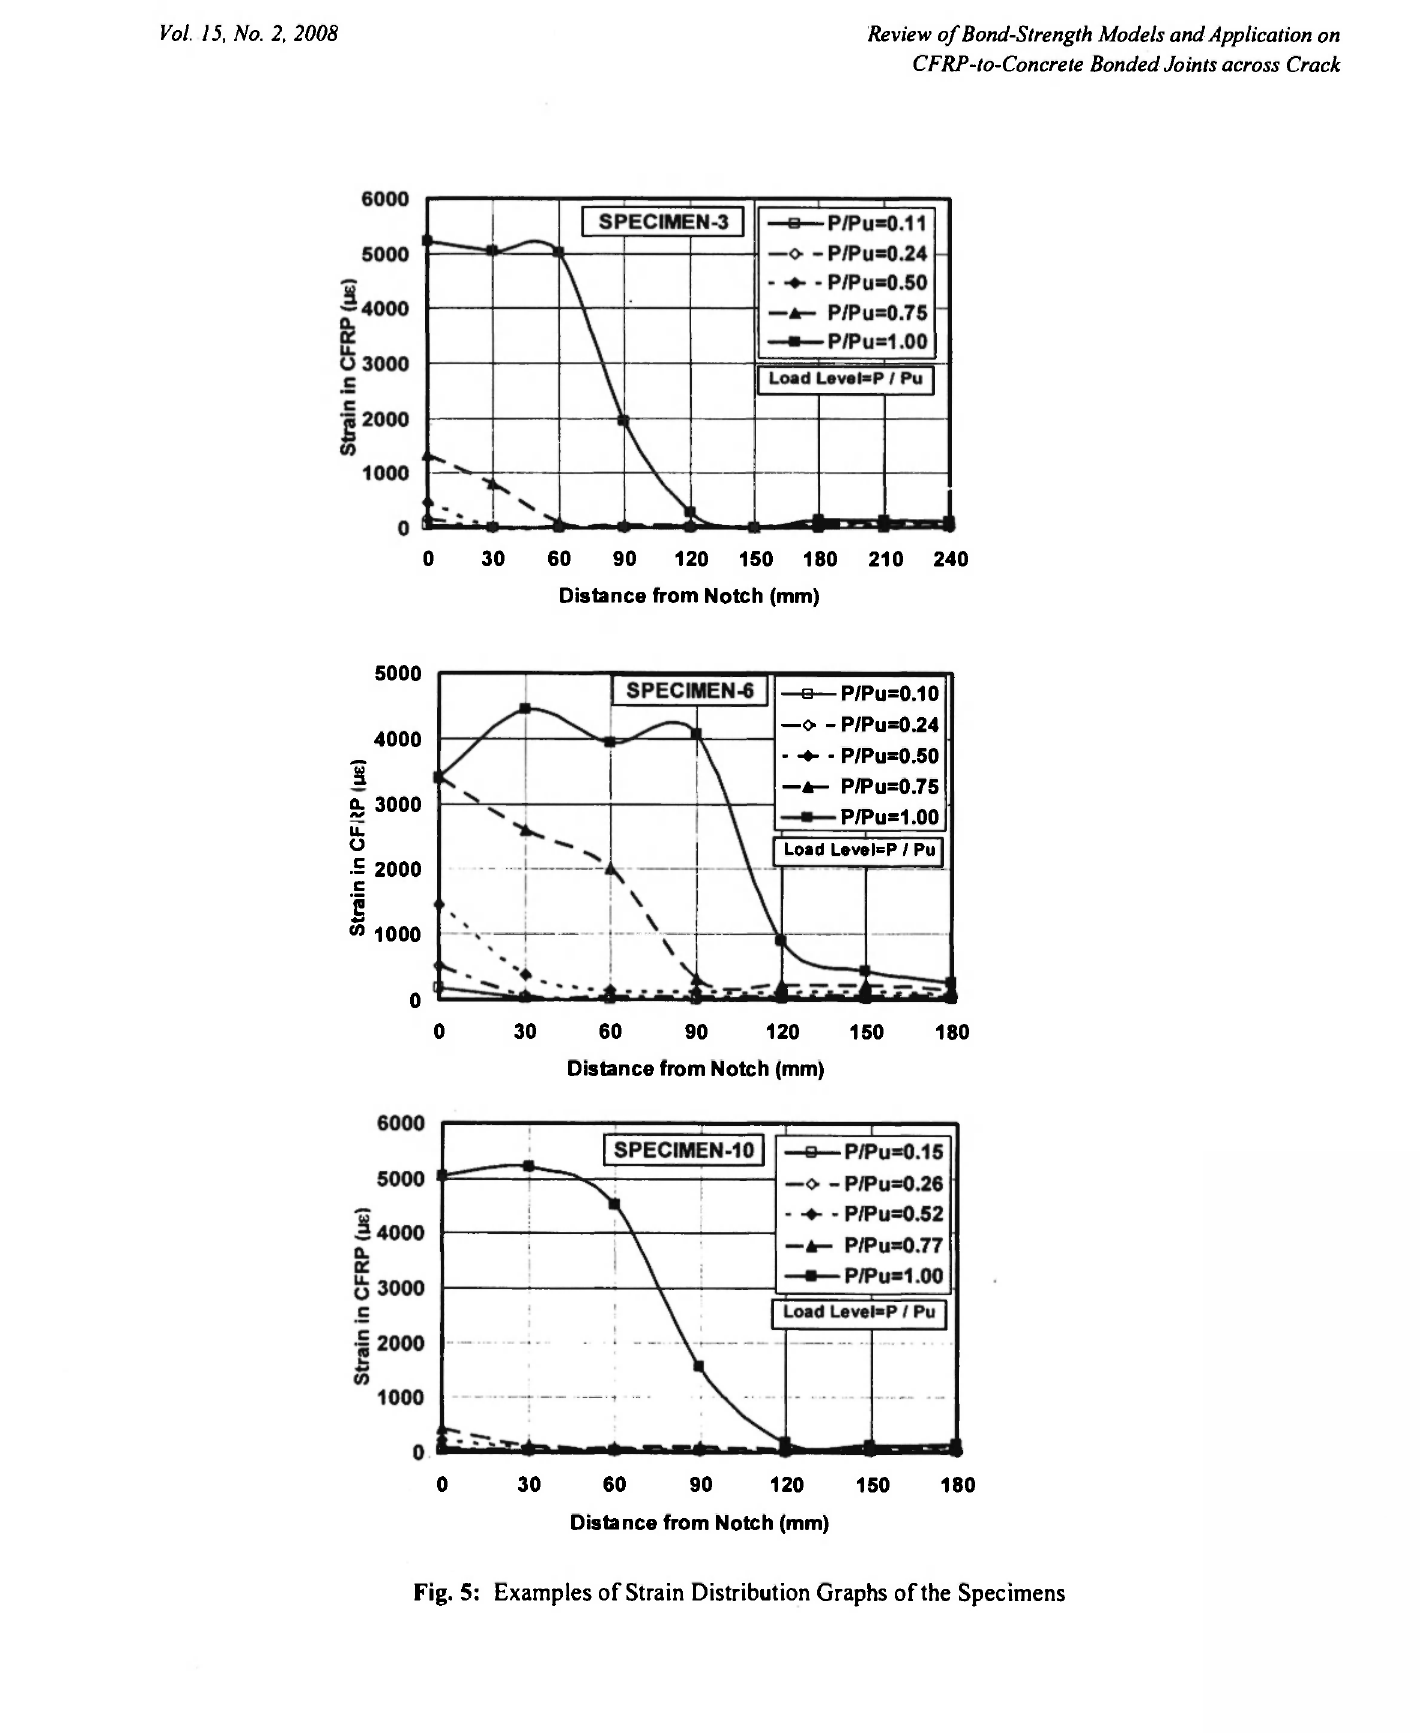
Fig. 5: Examples of Strain Distribution Graphs of the